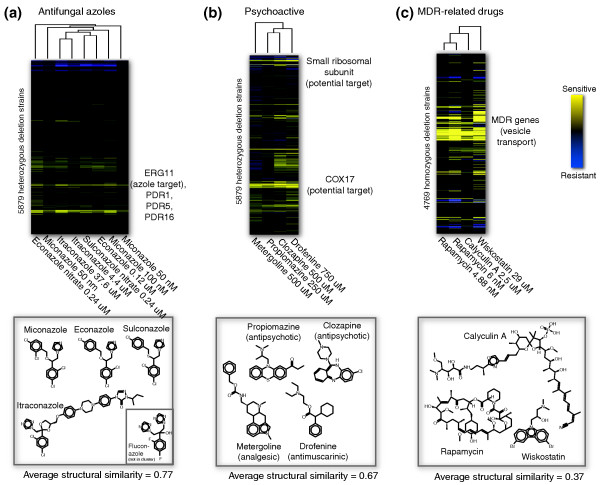
Compound clusters, extracted from genome-wide two-way clustering on the complete dataset (using all genes and all compounds). (a) Antifungal azoles in the heterozygous data, with high structural similarity. All induce sensitivity in strains deleted for ERG11, an azole target, and related pleiotropic drug resistance (PDR) transport-related genes; fluconazole (inset) did not appear in this cluster, though it is also thought to target Erg11. (b) Psychoactive compounds that target dopamine, serotonin, and acetylcholine receptors in human; these compounds cluster in the heterozygous dataset based on inhibition of small ribosomal subunit genes and Cox17, potential targets in both yeast and human. (c) Examples of drugs with similar homozygous fitness profiles; the similarity is due to shared sensitivity of strains deleted for multi-drug resistance (MDR) genes with roles in vesicle-mediated transport.